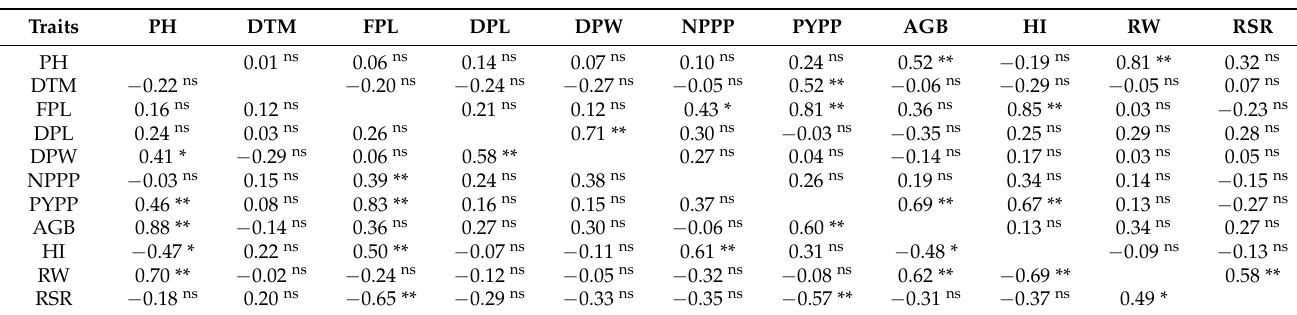
Table 6. Pearson correlation coefficients showing the magnitude of associations of phenotypic traits among okra accessions under drought-stressed (upper diagonal) and non-stressed (lower diagonal)